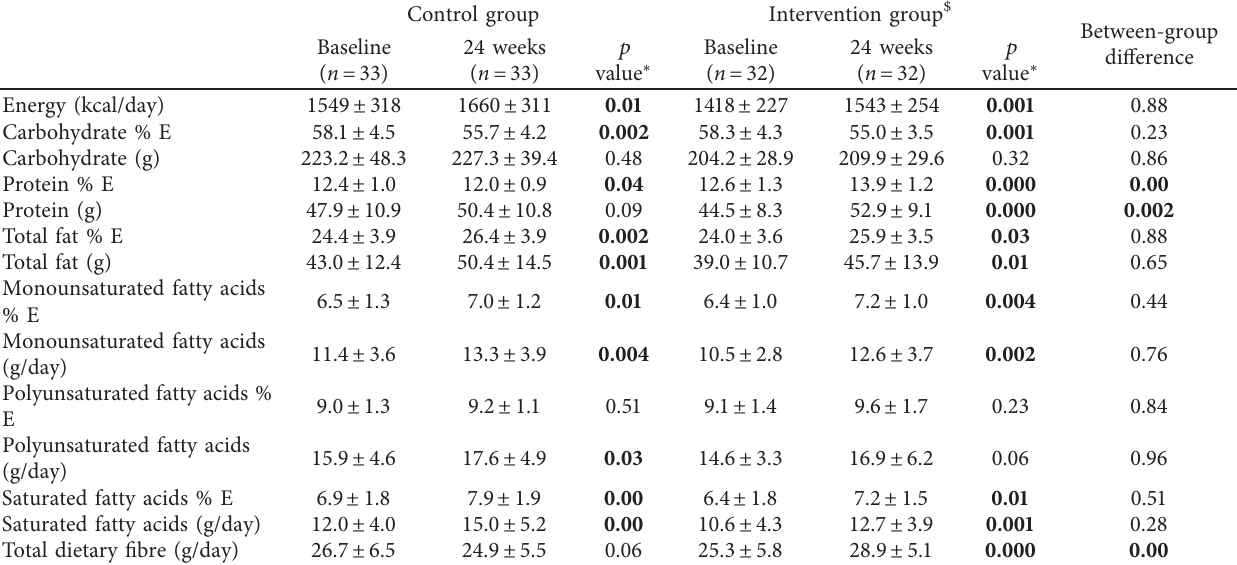
Table 3: Change in nutrient intake of control and intervention groups over 24 weeks ( n �